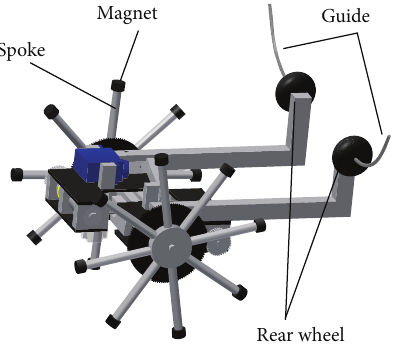
Figure 1: Conceptual design of outer-pipe inspection robot.